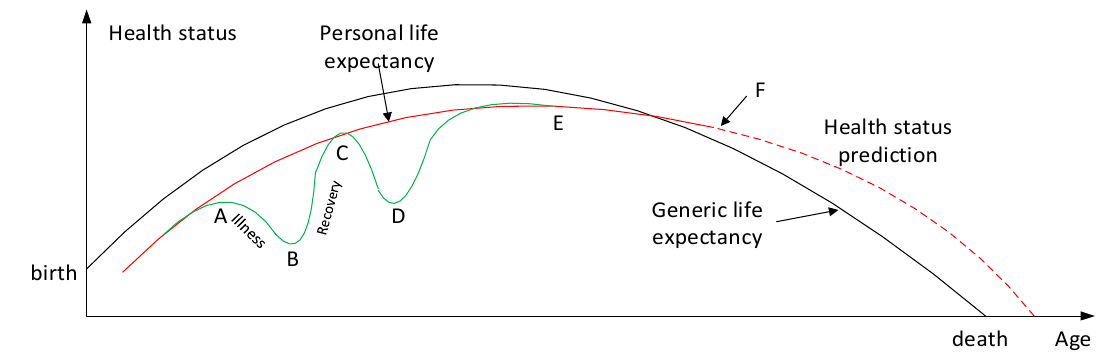
Figure 1. Health Status and personalized Life Expectancy (Adapted from [7]).